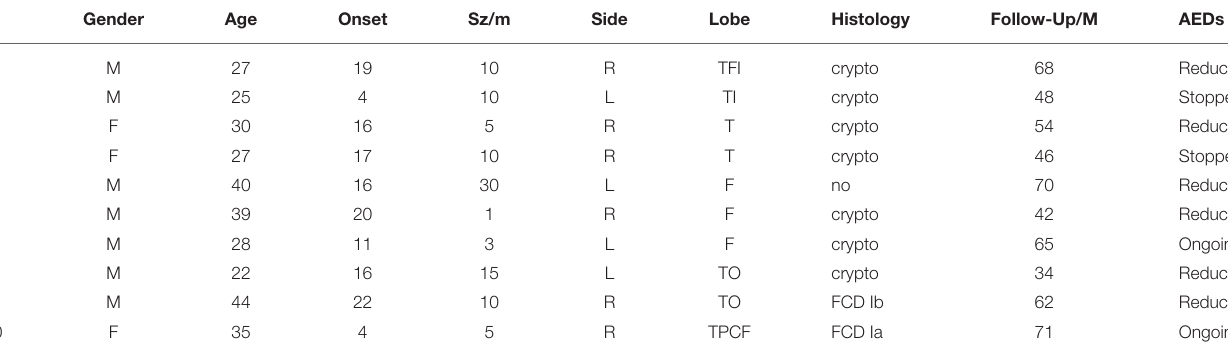
TABLE 1 | Main clinical features, epileptogenic zone (EZ) localization performed by the standard methods, and surgery outcomes for the patients enrolled in this study.